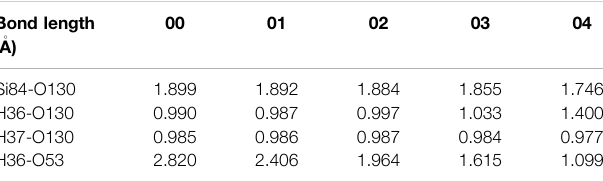
TABLE 5 | Changes in bond length for the reaction of H 2 O and P b1 defect with AOD con fi guration at random position 2. Bond length ( (cid:1)